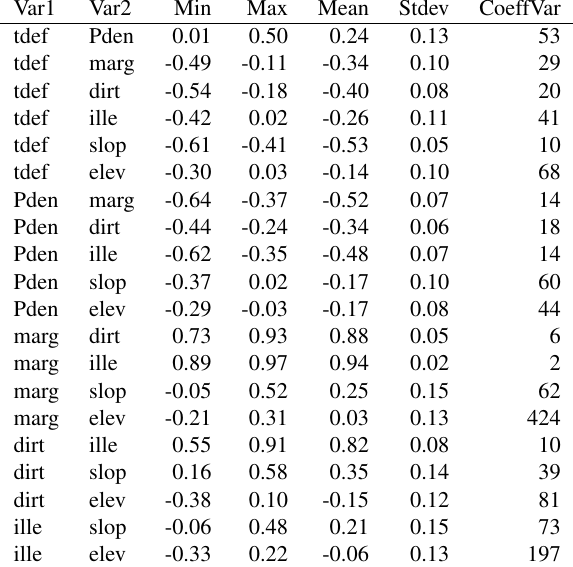
Table 3: Minimum, maximum, mean, standard deviation and co- efficient of variation of the values of the Pearson coefficient of correlation with 35 units (zoning effect)